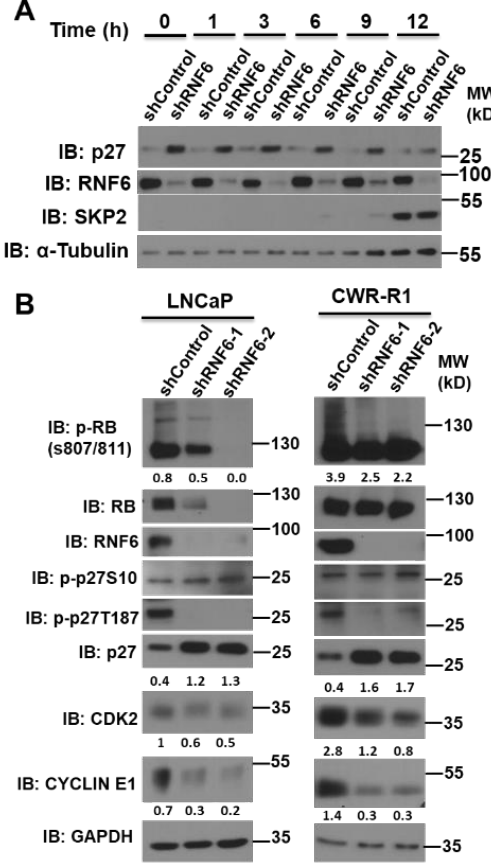
Figure 5. RNF6 knockdown leads to p27 accumulation in early G1 and reduced Rb phosphorylation. ( A ) CWR-R1 cells were transduced wither either control sRNA or shRNF6. After 48 h of transduc- tion, cells were synchronized in G0/G1 by serum withdrawal for 48 h. Ten percent final serum was added back and cells were harvested at indicated time points. Cells lysates were prepared and im- munoblotted as shown. ( B ) CWR-R1 and LNCaP cells were transduced with either control shRNA or shRNF6. After 72 h of transduction, cell lysates were prepared and subjected to Western blot analysis as shown.